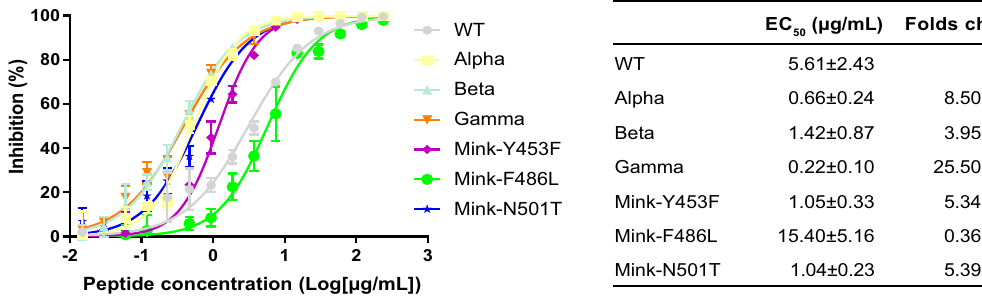
Fig. 5 Neutralization of SARS-CoV-2 variants by hACE2. The EC 50 values and folds change values are shown on the right panel. The folds change was normalized to WT, and the EC 50 values are presented as the mean ± SEM of three independent replicates ( n = 3). The representative results from three experiments are